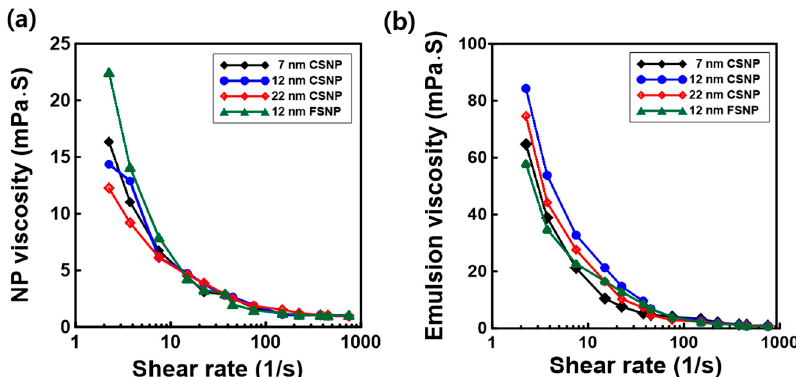
Figure 8. Apparent viscosities of ( a ) NPs and ( b ) NP-stabilized emulsions as a function of shear